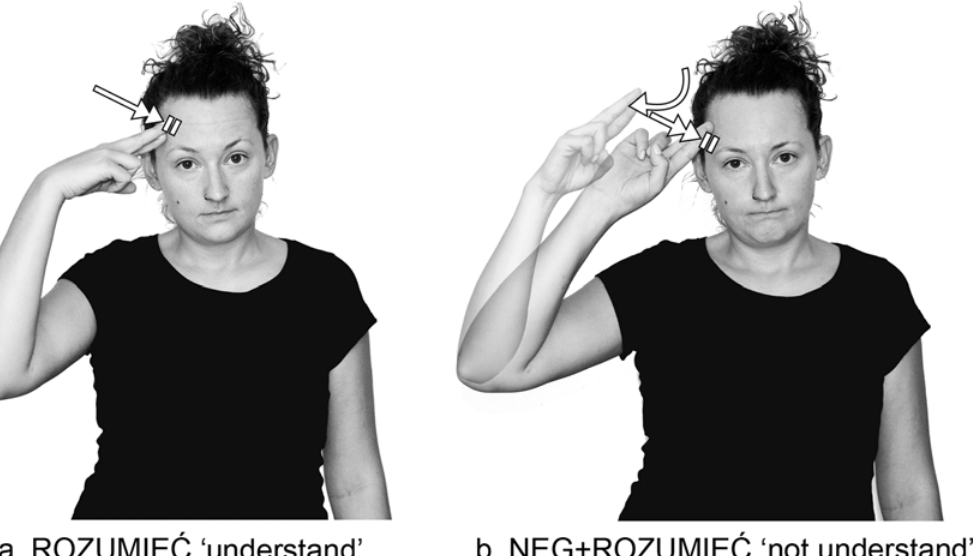
Fig 5. Handshape and location assimilation in the prefixed sign NEG+ROZUMIE Ć . (A) the lexical base ROZUMIE Ć ‘ understand ’ (B) prefixed sign NEG+ROZUMIE Ć ‘ not understand ’ . The individual in this figure has given written informed consent (as outlined in PLOS consent form) to publish these case